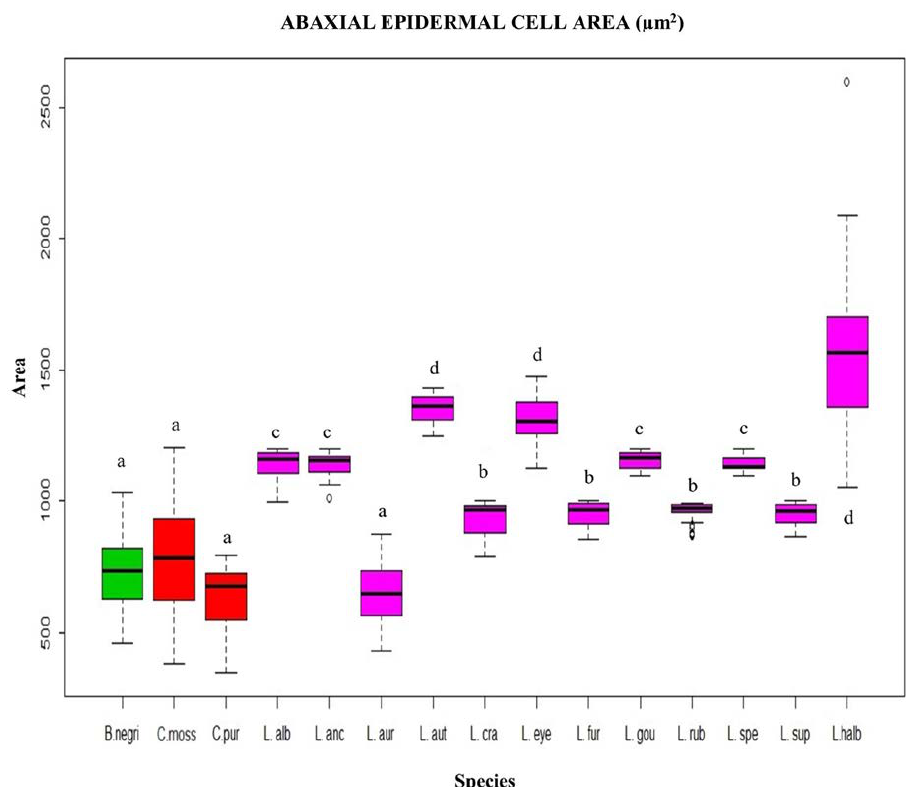
Figure 4. Box plot of the abaxial epidermal cell area, evaluated by species. Each color identifies the genera: Broughtonia (green), Cattleya (red) and Laelia (pink). Each letter represents a group, according to Dunnett’s post hoc analysis. a = 600 to 800 µ m 2 , b = 801 to 1000 µ m 2 , c = 1001 to 1200 µ m 2 , d = 1201 to 1400 µ m 2 .